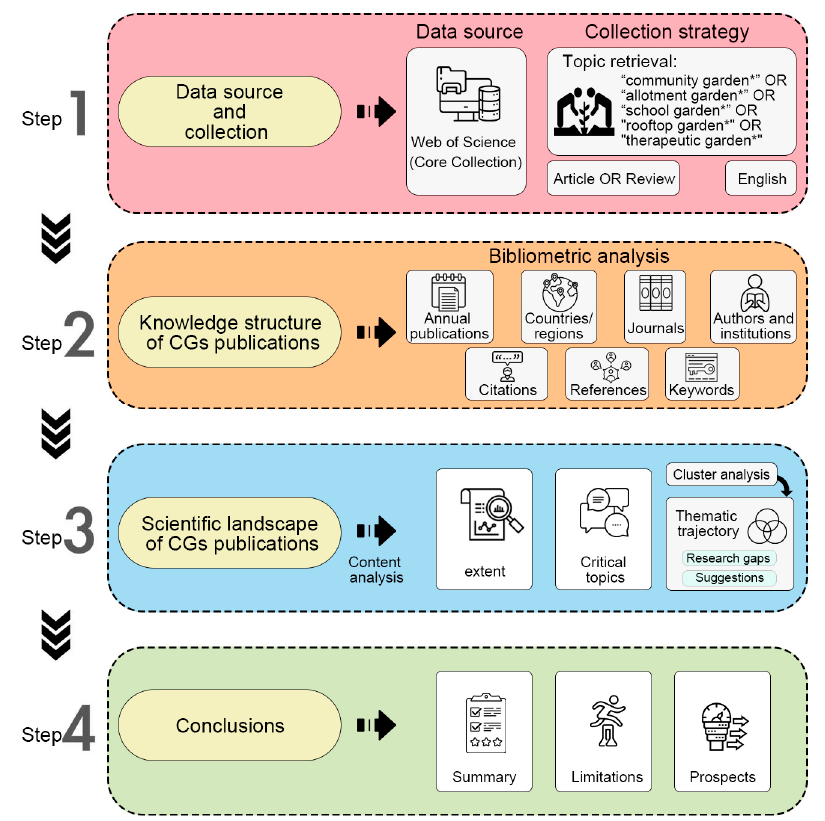
Figure 2. Research Figure 2. Research framework.